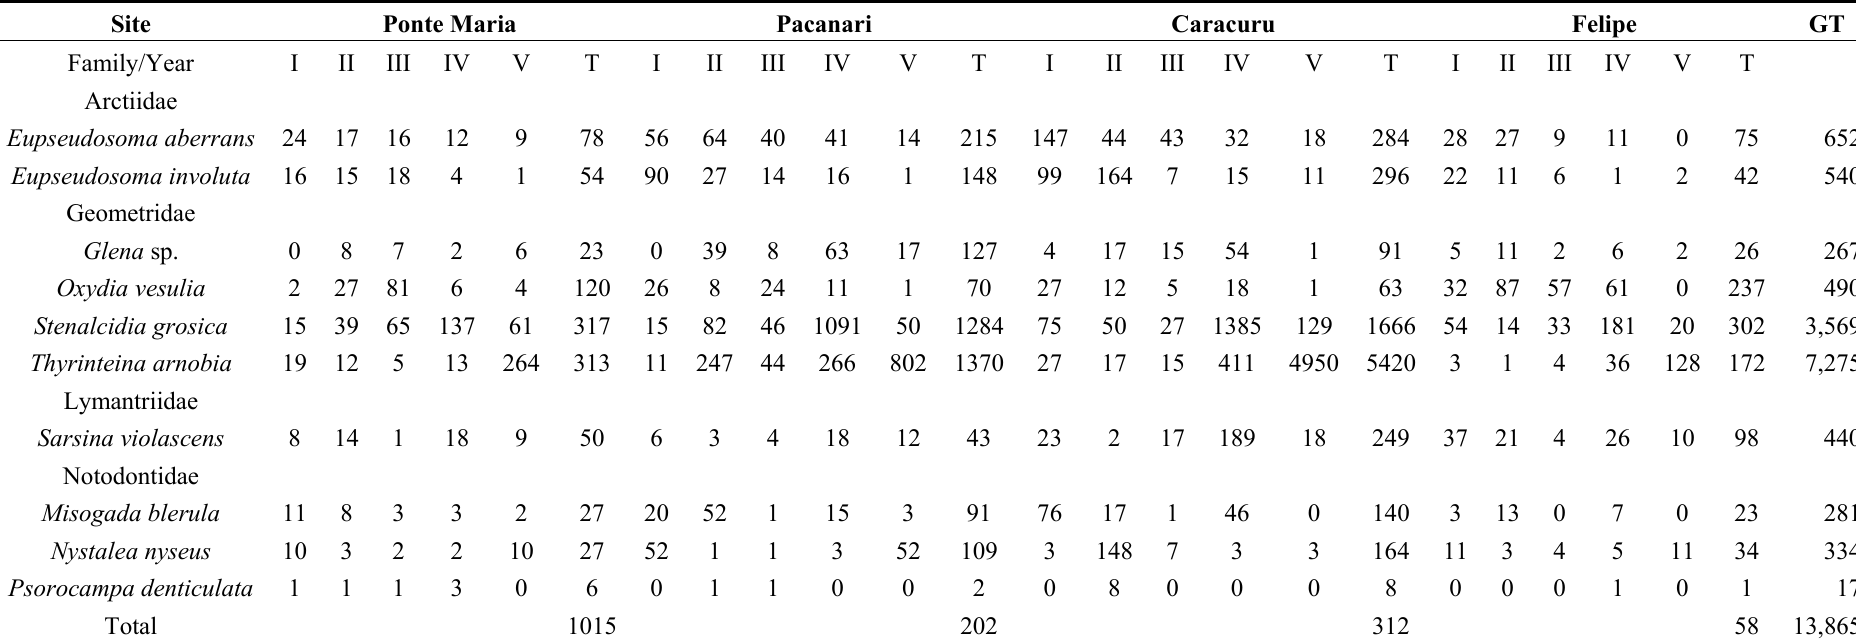
Table 2. Number of individuals of Lepidoptera primary pest species collected in Eucalyptus urophylla plantations in Monte Dourado, Pará and Amapá States, Brazil. T is Sub-total; GT is Grand Total.